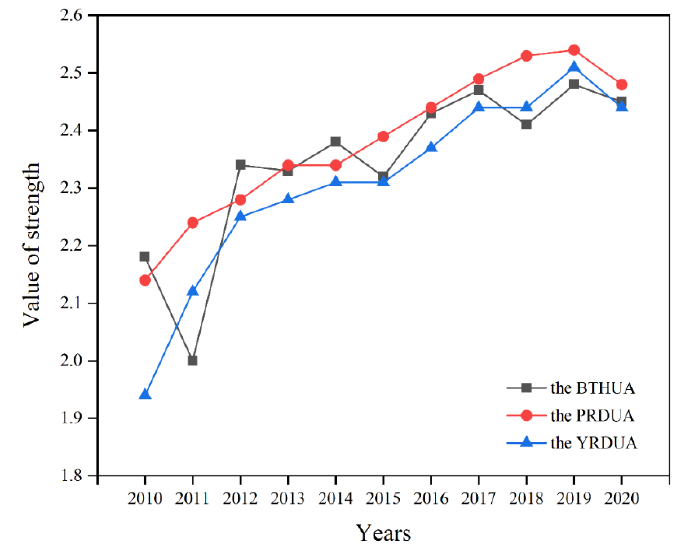
Figure 2. Arithmetic mean of housing prices’ association strength in the BTHUA, the PRDUA, and the YRDUA from 2010 to 2020.